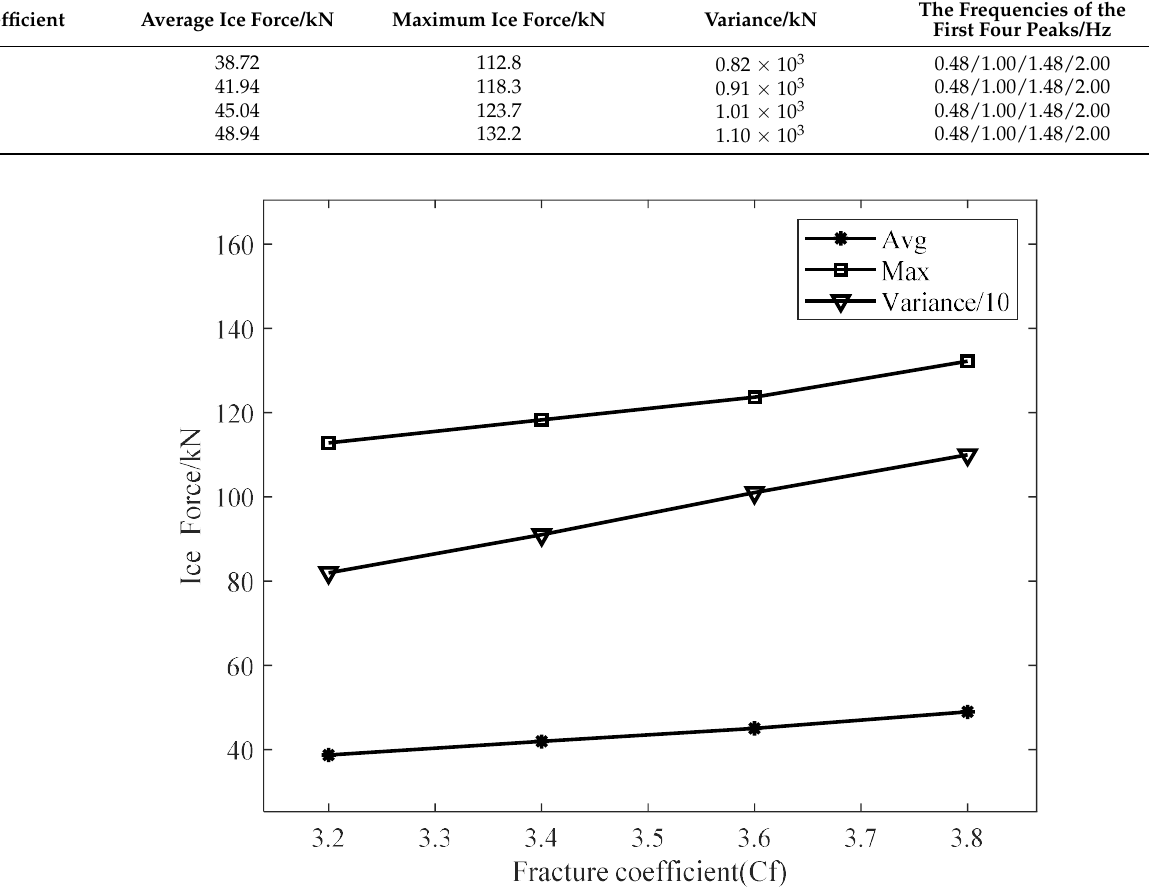
Table 6. Statistics of ice force under different fracture coefficient ( C f ).